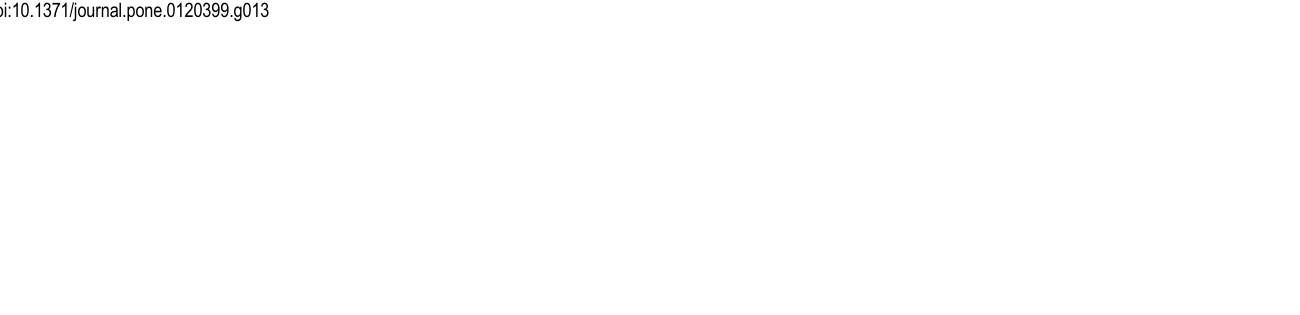
Fig 13. Comparisons of the segmentation results for WM and GM among Li ’ s model, LSACM and our model. Column 1 are the original images. Column 2 is the ground truth of original images. Column 3 to 5 is the final segmentation results of Li ’ s method, LSACM and our method, respectively. Rows 1, 3 and 5 are WM, and rows 2, 4 and 6 are GM. All WM and GM are displayed in